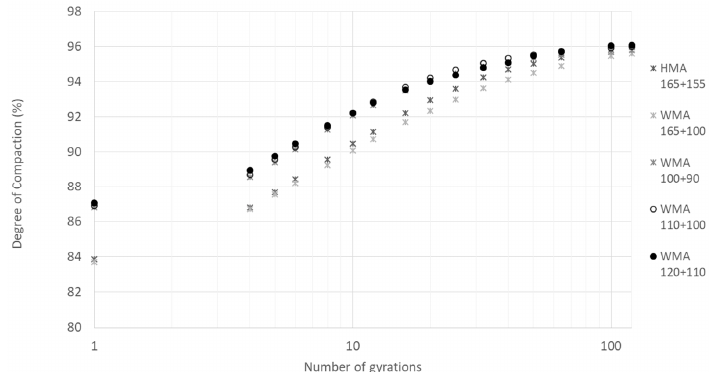
Figure 10. Gyratory compaction curves for the tested mixtures and temperatures.